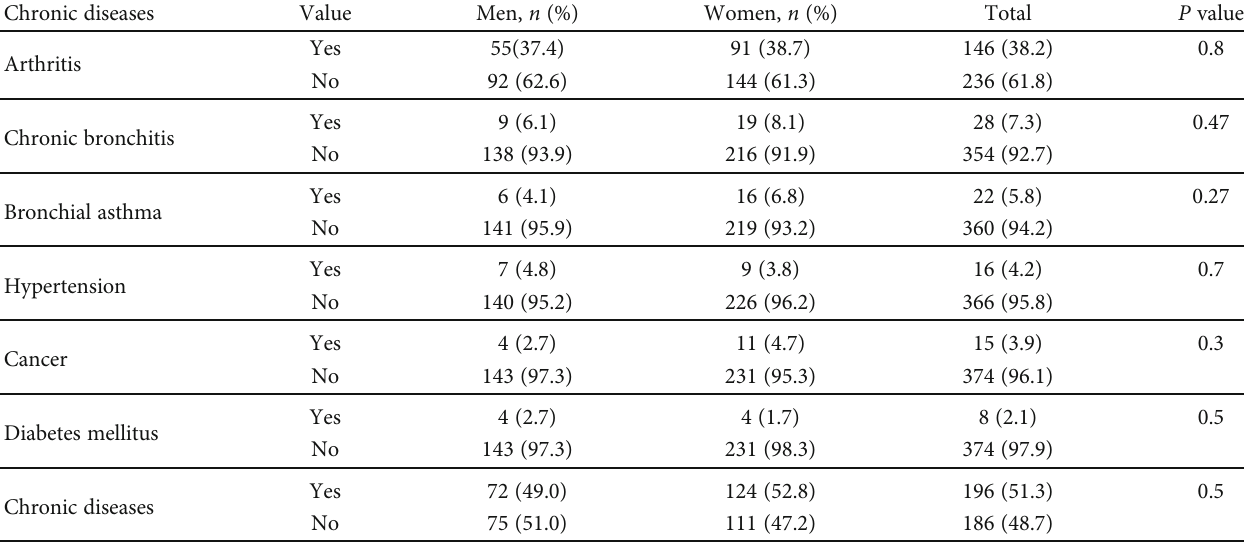
Table 4: Di ff erence in prevalence of chronic diseases by gender among people living with HIV at HUCSH, April 2016. Chronic diseases